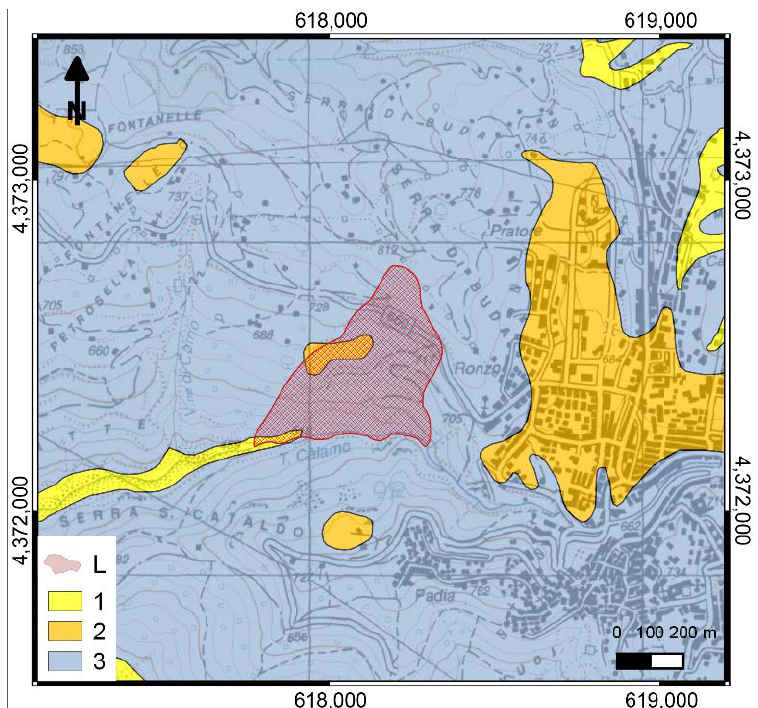
Figure 3. Lithological sketch of the Serra di Buda landslide at Acri. Key: (1) Alluvium, colluvium and residual soil; (2) conglomerate and sandstone; (3) Igneous and medium-high grade metamorphic rock. The landslide (L) is marked by a red hatched polygon. Topographic base map after 1:25,000 IGMI sheets; lithological map after [47], Geological map of Calabria (scale 1:25,000), mod.